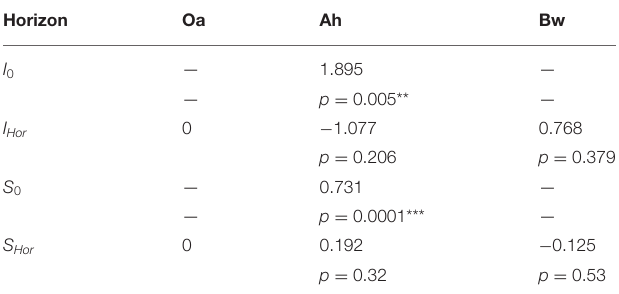
TABLE 4 | Coefficients of the regression model of cumulated P -influx over cumulated citrate efflux (Equation2 displayed in Figure 4 ), with p -values of coefficients: **<0.01,